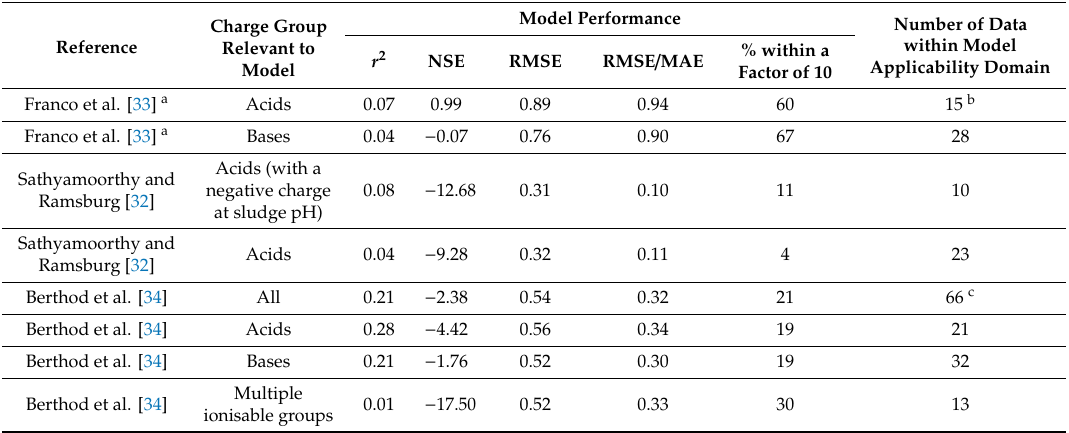
Table 4. Assessment of the performance of previously published sludge sorption models in their ability to predict sludge sorption coe ffi cients.